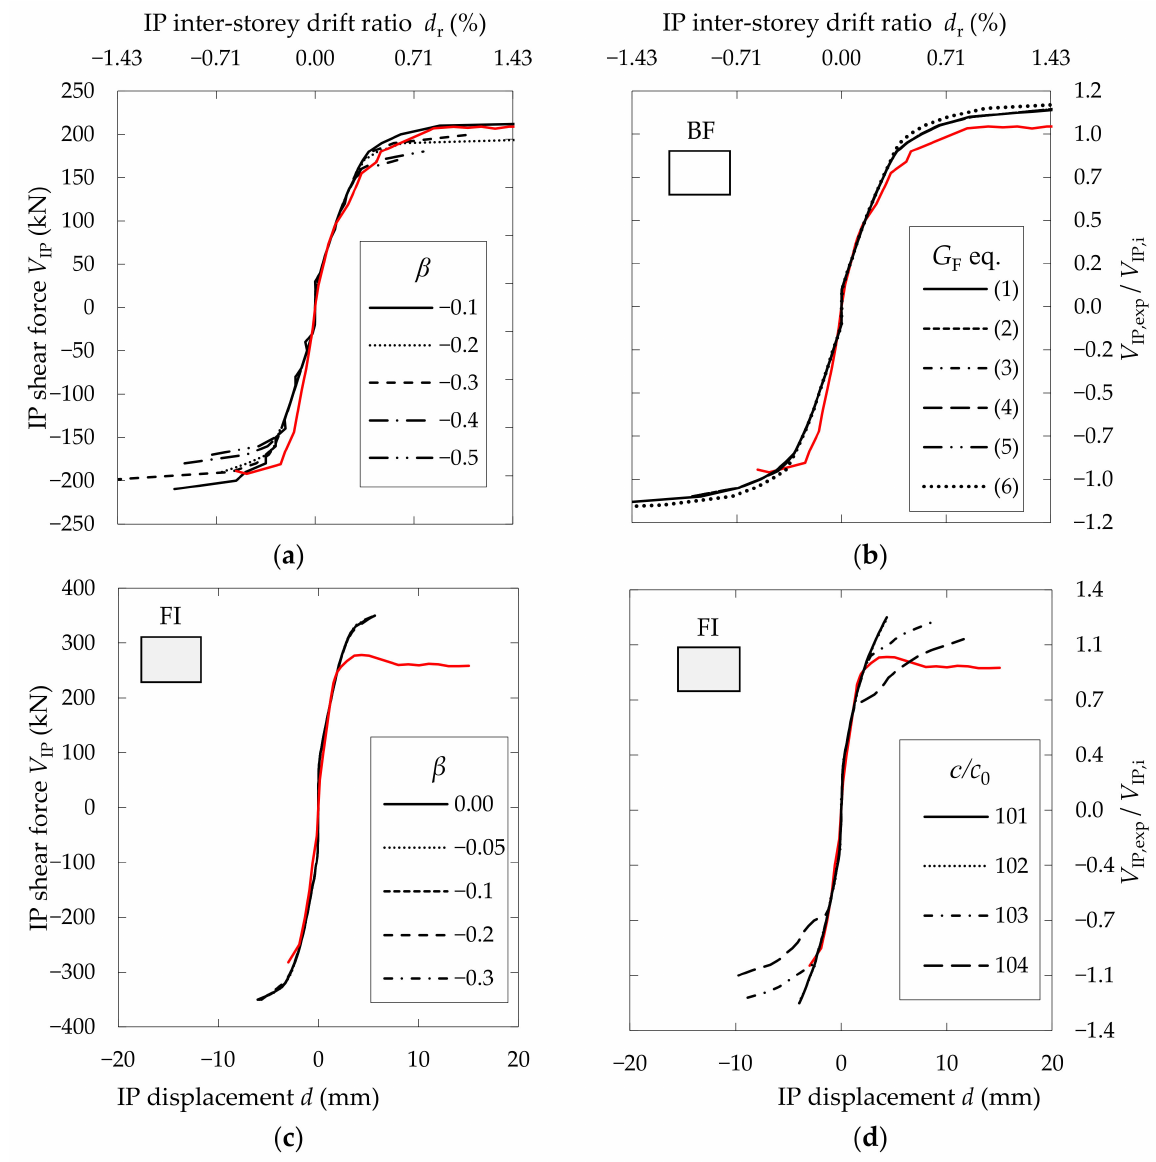
Figure 20. Examples of IP calibration process: ( a ) bare rc frame case β parameter influence investigation; ( b ) bare rc frame case G F parameter influence investigation; ( c ) full-infilled rc frame case β parameter influence investigation; ( d ) full-infilled rc frame case c/c 0 parameter influence